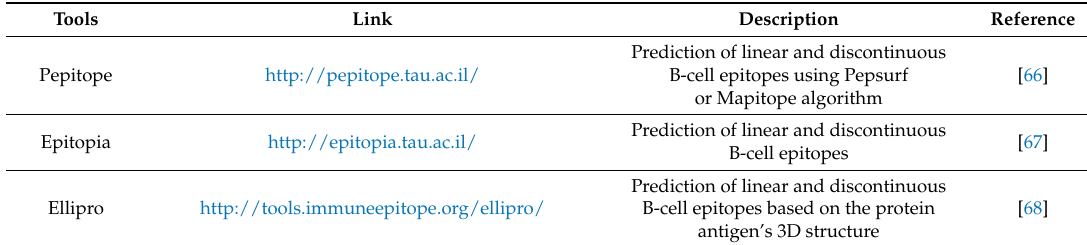
Table 1. Selected web tools for in silico B-cell epitope